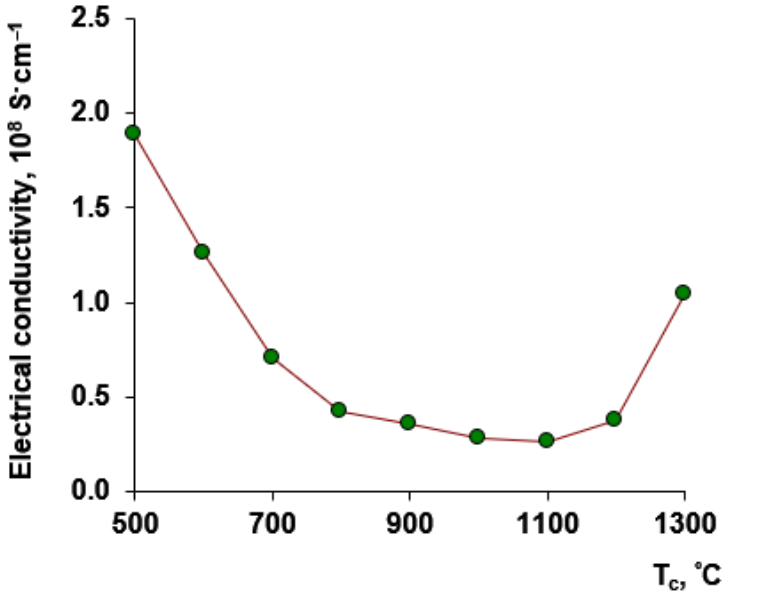
Figure 4. DC electrical conductivity of MgFe 2 O 4 powders for samples calcined at different temperatures.